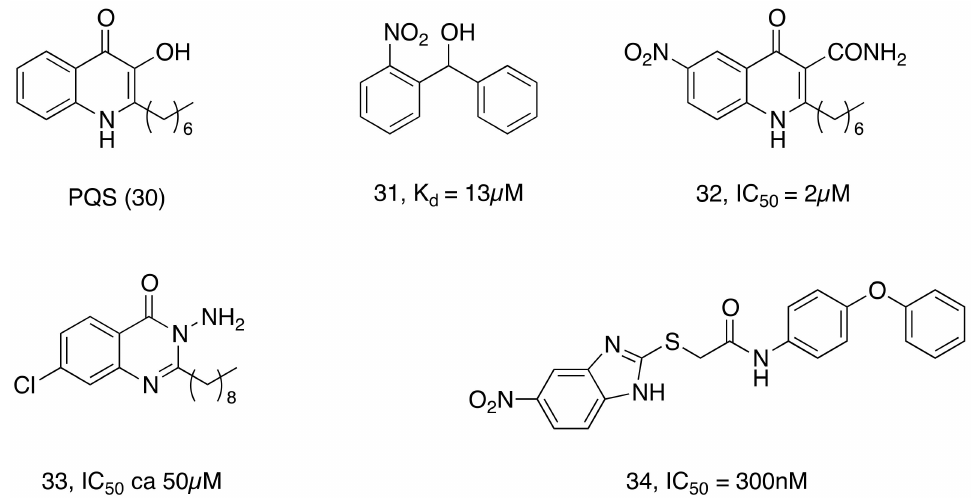
Figure 8. Chemical structures of Quorum sensing (QS) inhibitors discussed in this